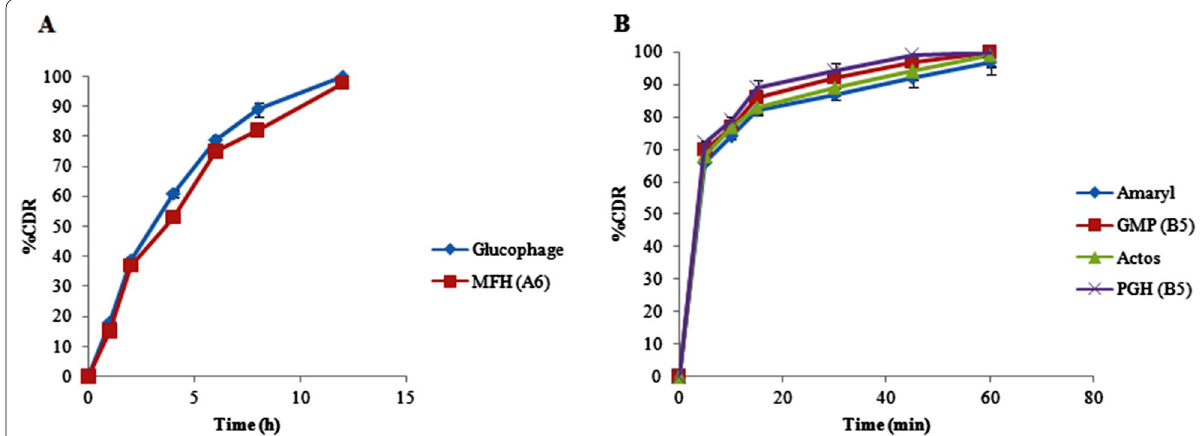
Table 6 Pharmacokinetic parameters of pellet formulations Pharmacokinetic